Question: Name the type of graph shown.
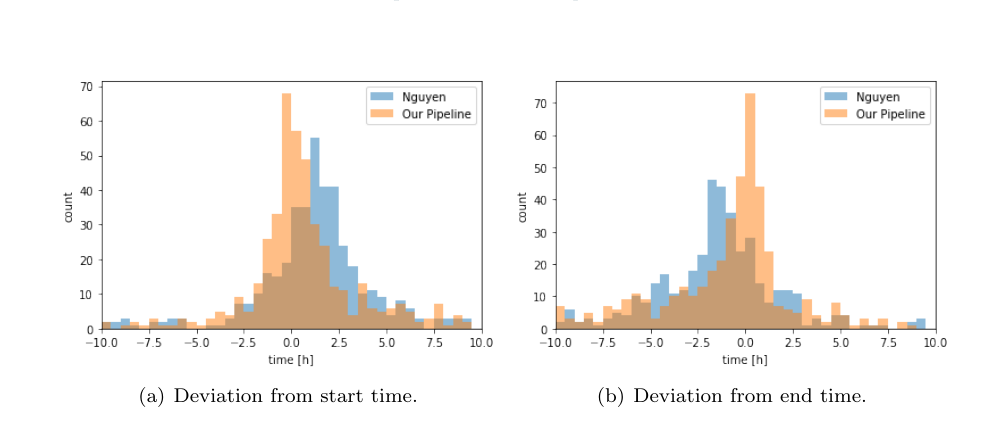
Answer: histogram